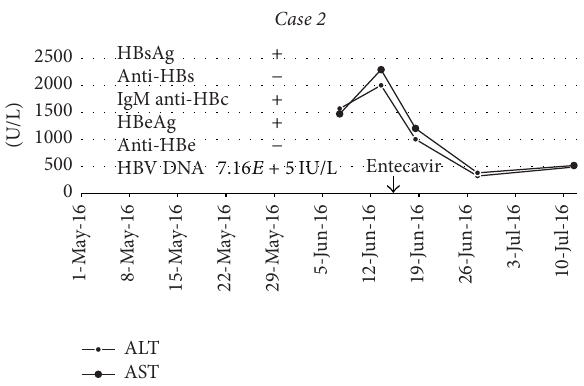
Figure 2: Liver enzymes and HBV tests in relation to entecavir